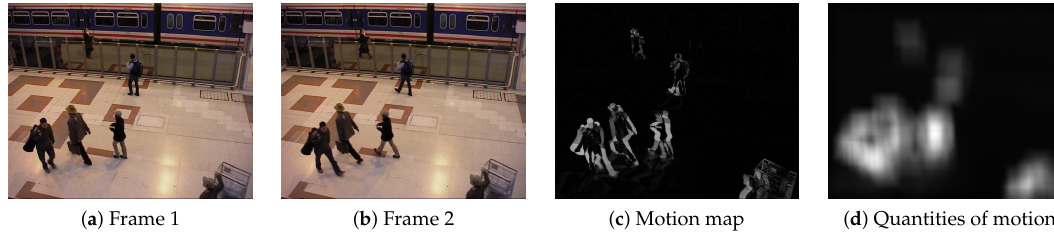
Figure 4. Illustration of the difference between motion scores and quantities of motion. The absolute difference of pixel intensities between frames ( a ) and ( b ) results in the motion map ( c ). The estimation step applied on this motion map for N = 8 is displayed in ( d ). For the purpose of visualization, the quantities of motion in (d) have been normalized with respect to the largest quantity in the